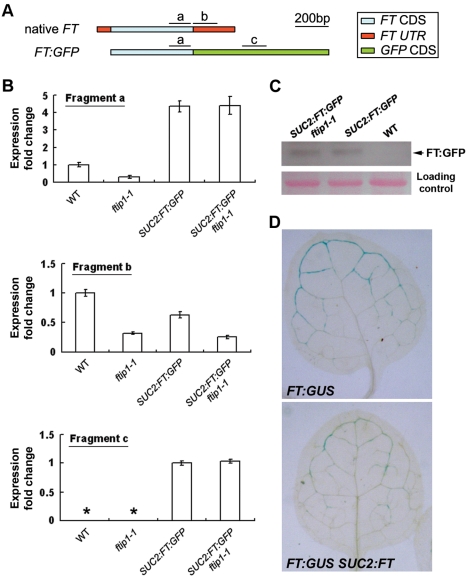
FTIP1 does not regulate FT mRNA or protein stability.(A) Schematic diagrams showing native FT and transgenic SUC2:FT:GFP transcripts. The fragments labeled with a, b, and c indicate amplicons in real-time PCR analyses shown in (B). Fragments a, b, and c were amplified with primers FT-F and FT-R, FT(UTR)-F and FT(UTR)-R, and GFP-F1 and GFP-R1 (Table S1), respectively. (B) Examination of steady-state levels of FT or FT:GFP mRNA in wild-type and ftip1-1 backgrounds. Amplification of fragment a, which detects the amplicon in both native FT and transgenic FT:GFP transcripts, shows that native FT expression is downregulated in ftip1-1 versus wild-type, whereas total FT expression (including minor native FT and major transgenic FT:GFP expression) remains unchanged in SUC2:FT:GFP ftip1-1 versus SUC2:FT:GFP. Although the former indicates that FTIP1 affects the steady-state levels of native FT expression, the latter implies that FTIP1 does not directly affect FT mRNA stability. Amplification of fragment c, which only detects the amplicon in transgenic FT:GFP transcripts, further supports that FTIP1 does not directly affect FT mRNA stability as transgenic FT:GFP expression is not changed in ftip1-1. Amplification of fragment b, which only detects the amplicon in native FT transcripts, shows that native FT expression is also downregulated in SUC2:FT:GFP transgenic plants. 9-d-old seedlings grown under LDs were harvested for expression analysis by quantitative real-time PCR. Results were normalized against the expression of TUB2. Asterisks indicate that the expression of fragment c was undetectable in wild-type and ftip1-1 seedling. Error bars indicate SD. (C) Western blot analysis using anti-GFP antibody shows the comparable abundance of FT:GFP protein in wild-type and ftip1-1 plants. Ponceau S staining of the membrane is used as a loading control. (D) GUS staining of rosette leaves of 9-d-old FT:GUS and FT:GUS SUC2:FT seedling.